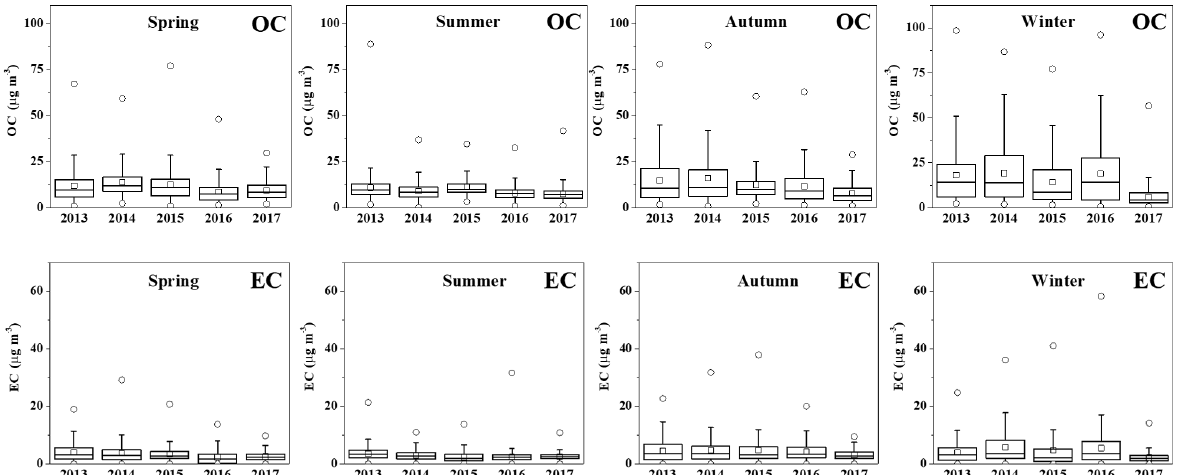
Figure 4. Seasonal variations in OC and EC concentrations from March 2013 to February 2018. The mean (square in the box), median (horizontal line in the box), 25th and 75th percentiles (lower and upper ends of the box), 10th and 90th percentiles (lower and upper whiskers), and maximum and minimum (hollow circles) are